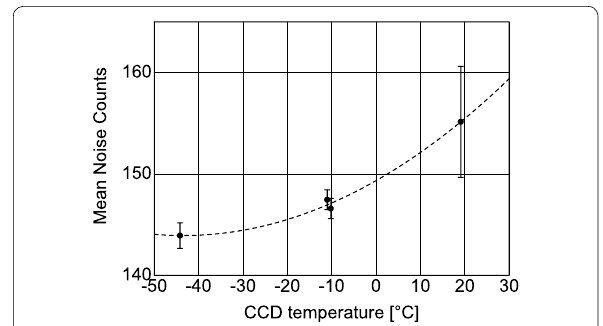
Fig. 4 Temperature dependence of the CCD dark counts through the readout electronics